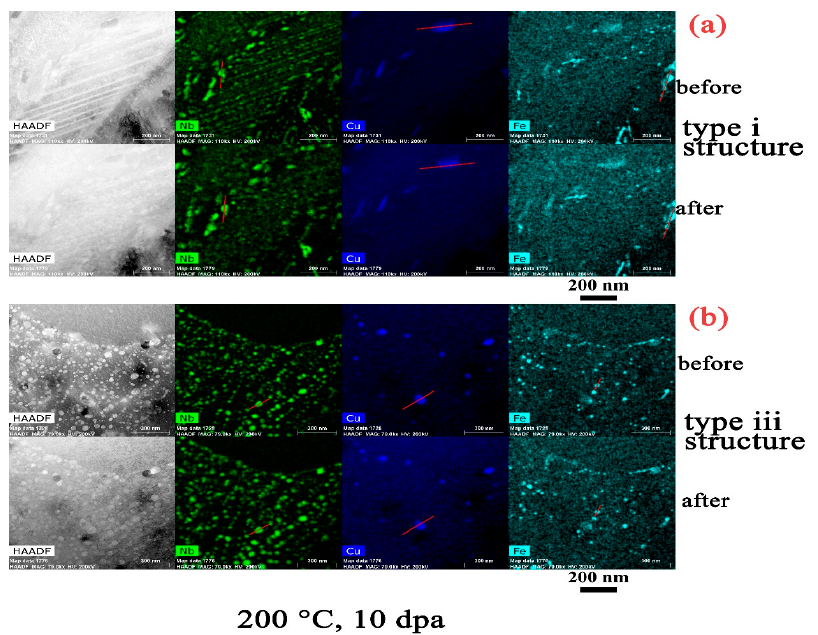
Figure 3. HAADF and Chemi-STEM micrographs showing the distribution of Nb, Cu, and Fe alloying elements before and after heavy ion irradiation at 200 °C to 10 dpa in ( a ) type i and ( b ) type iii structures. Red lines in the maps indicate the precipitates used for the element distribution line profile measurement.